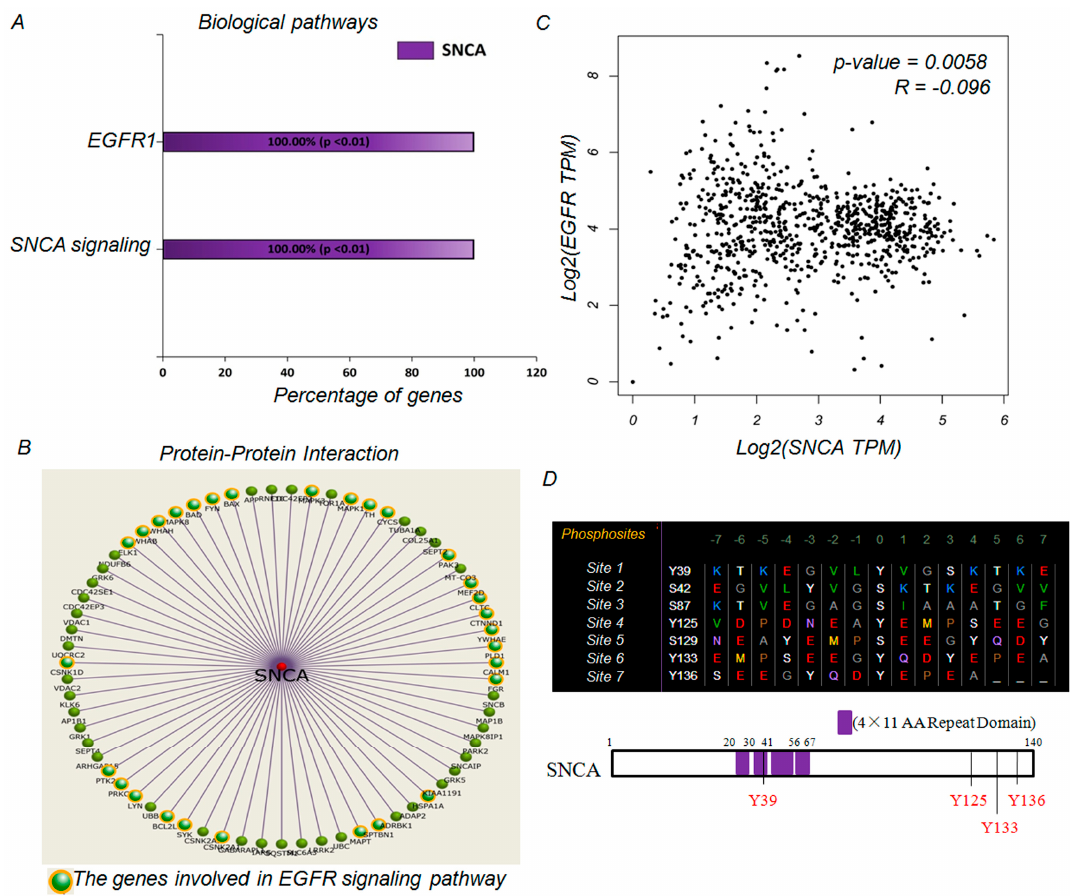
Figure 5. SNCA is modulated by the EGFR signaling pathway. ( A ) FunRichsoftware identified the EGFR1 signaling pathway as one of the top significant GO biological processes associated with SNCA . ( B ) The PPI network of SNCA interaction partners, created using the FunRich algorithm. ( C ) The GEPIA tool showed a negative correlation between SNCA and EGFR transcript levels in ADC tissues. ( D ) Putative EGFR phosphorylation sites were predicted in the SNCA protein sequence using the PhosphoNET website (http://www.phosphonet.ca/).